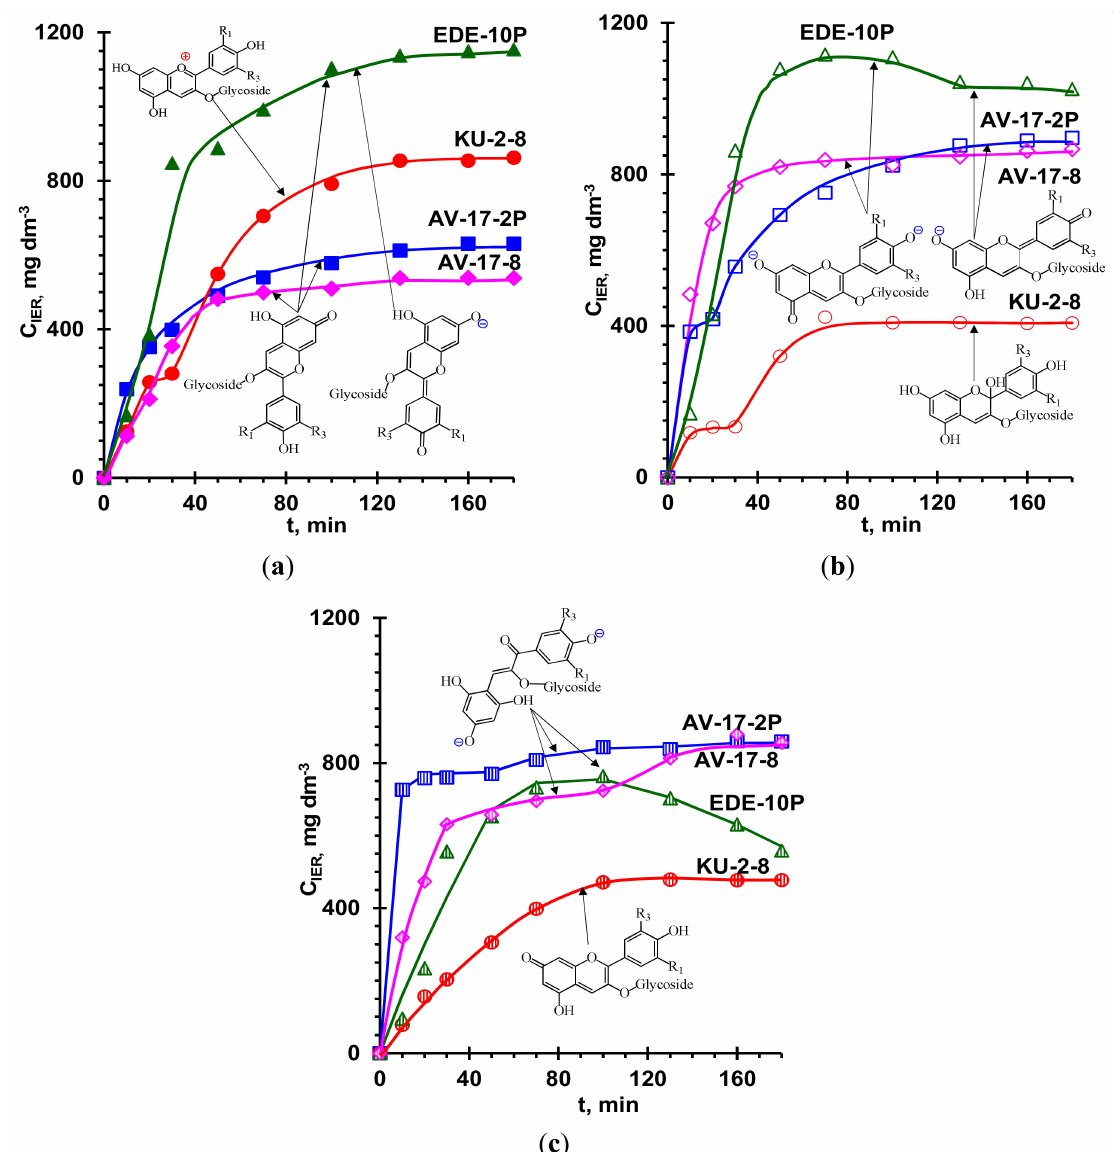
Figure 10. Kinetics of the anthocyanin adsorption by the ion-exchange resins from the aqueous solutions with initial anthocyanin concentration of 40 mg dm − 3 and pH 3 ( a ), 6 ( b ), and 9 ( c